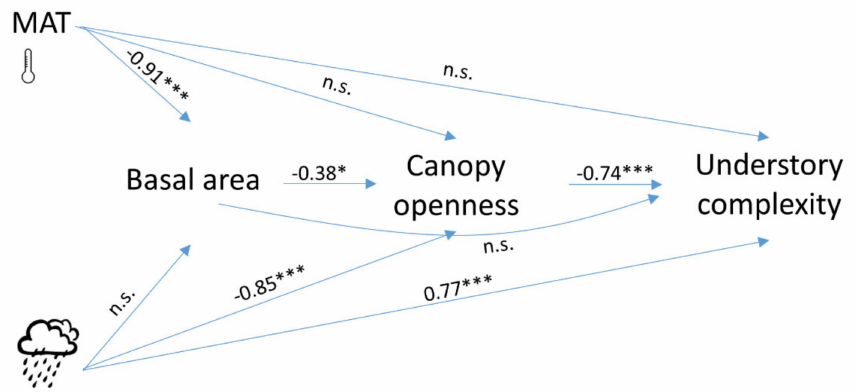
Figure 6. Graphical visualization of the relationships among all investigated explanatory variables and understory layer complexity accessed via Spearman’s rho and the according significance of the relationship. *** = p < 0.001; * = p < 0.05; n.s. = not significant. MAT stands for mean annual temperature; cloud symbol indicates “mean annual